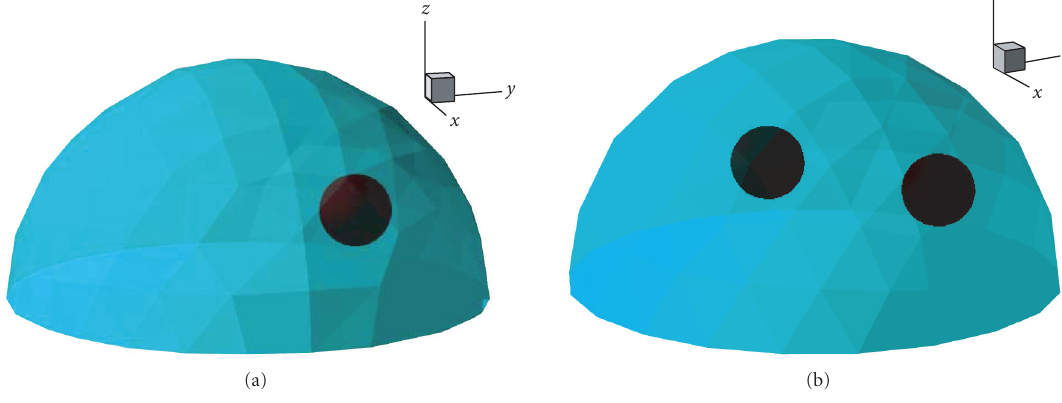
Figure 2: 3D phantoms mimicking the normal breast tissue and embedded tumor(s). Finite-element mesh is shown on the external surface. (a) Phantom I, with one tumor; (b) Phantom II, with two